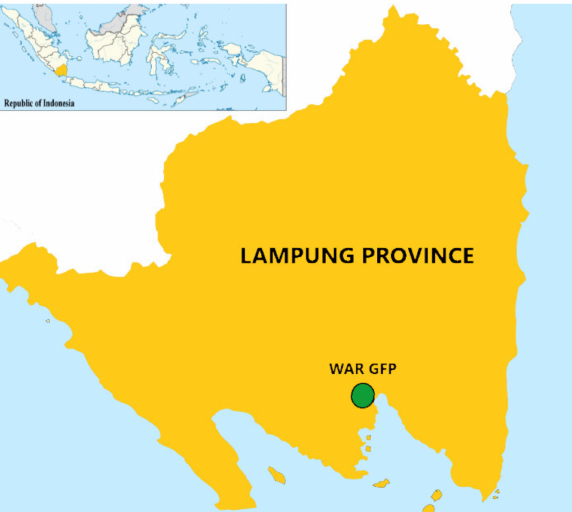
Figure 1. Research location at Wan Abdul Rachman Grand Forest Park (WAR GFP), Pesawaran District, Lampung Province, Sumatra,